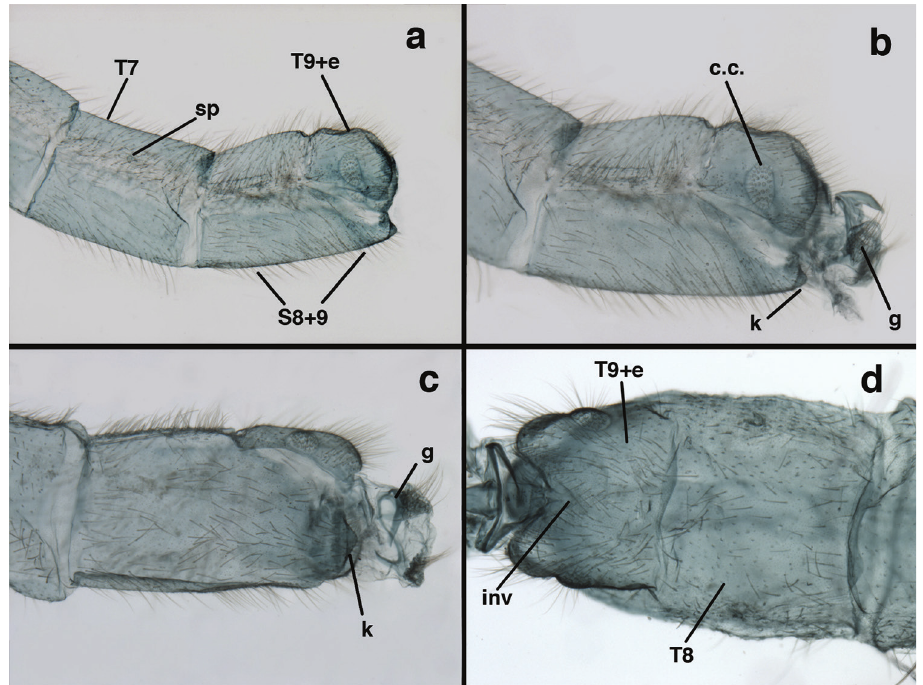
Figure 90. Ungla stangei Tauber, sp. n. Male abdomen (slightly teneral), ( a ) abdominal segments A7- terminus, lateral ( b ) terminalia, lateral ( c ) S8+9, ventral ( d ) T8, T9+ectoproct, dorsal [Note invagina- tion.]. c.c. callus cerci g gonarcal complex inv dorsal invagination of T9+ectoproct k sclerotized knob at tip of S9 sp spiracle S8+9 fused eighth and ninth sternites T7, T8 seventh, eighth tergites T9+e fused ninth tergite and ectoproct (all: Bolivia, La Paz; a–c paratype, CAS; d holotype, CAS). 1.88–2.22 mm long; fourth gradate cell 1.86–2.36 mm long), (3) heavy setation